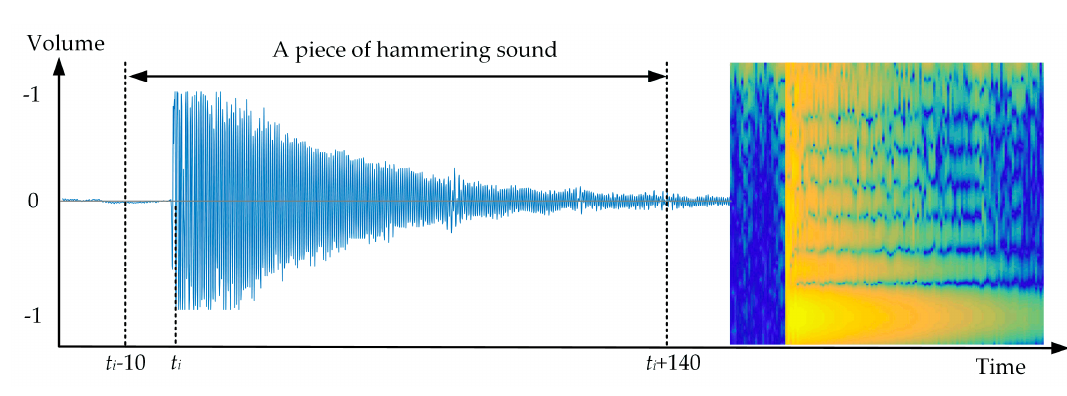
Figure 5. Process of producing spectrograms.